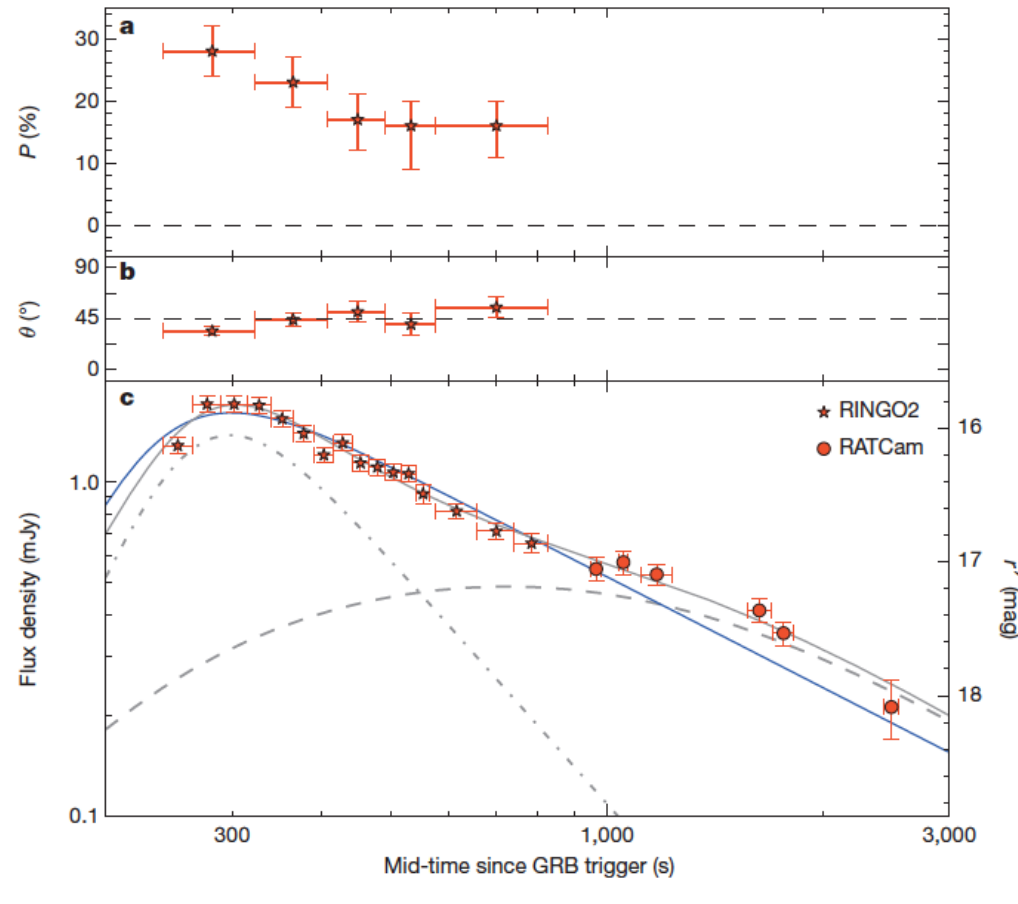
Figure 1. Evolution of optical polarization and brightness in GRB120308A. Evolution of ( a ) polarization degree P and ( b ) position angle θ . ( c ) Light curve. Model fits using one peak (blue solid line) or two peaks (broken grey line for each component). Figure from